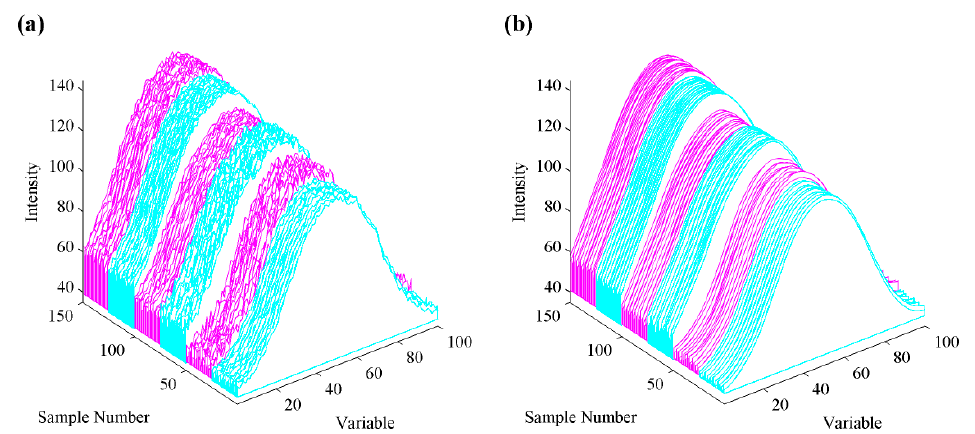
Figure 6. The framework of converting the rainbow image into the image feature vector in RGB color histogram.